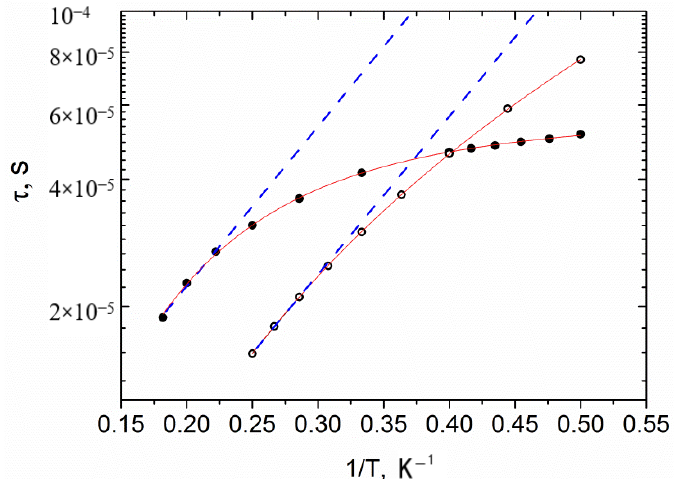
Figure 5. τ vs. 1 / T Plot for Complex 1 ( filled circles ) and 2 ( open circles ) under 1000 Oe dc-field. Blue dashed lines represent fitting by Orbach mechanism. Solid red lines represent fitting by Raman ( 2 ) and Raman+QTM ( 1 ) relaxation mechanisms.